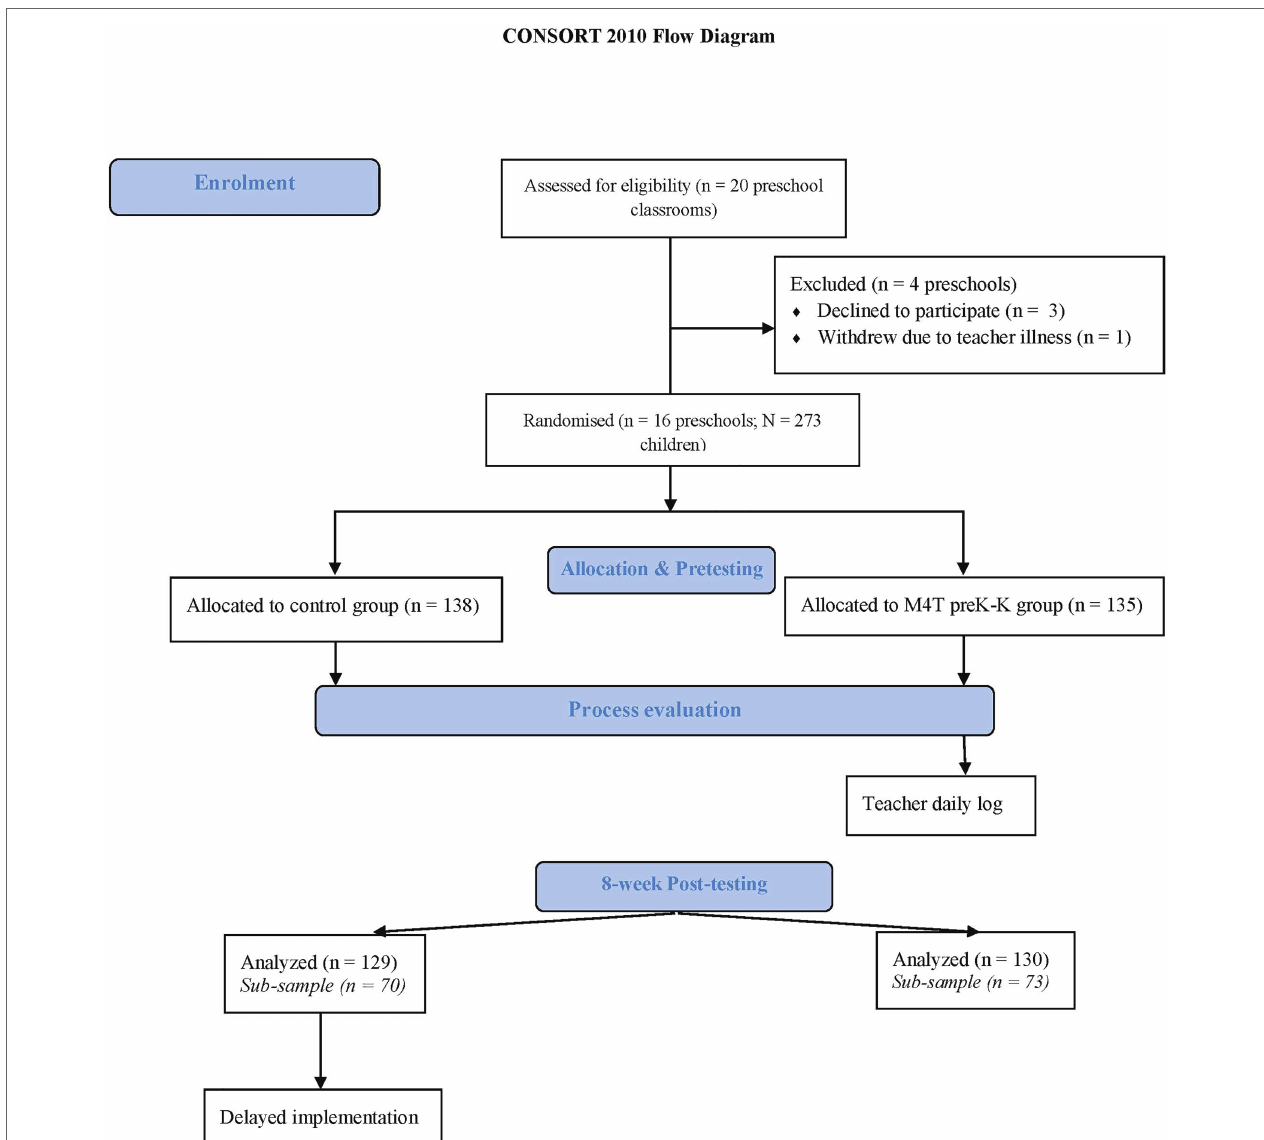
FIGURE 1 | Flow Chart of